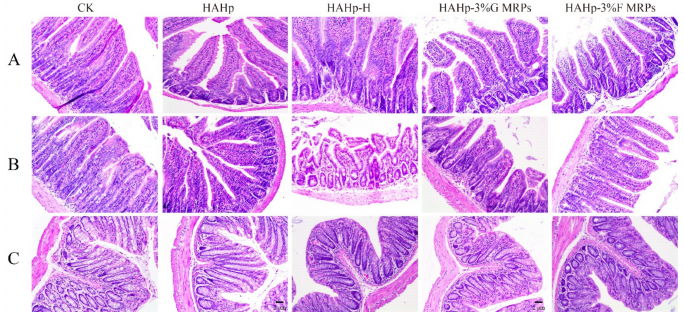
Figure 2. Histological analysis of intestine tracts after 30 days of oral gavage of HAHp, HAHp-H, HAHp-3%G MRPs, and HAHp-3%F MRPs compared to the CK (oral gavage of saline) by hematoxylin- eosin (H&E) staining. ( A ) Jejunum; ( B ) ileum, and ( C ) distal colon. Observation at 100 × magnification.